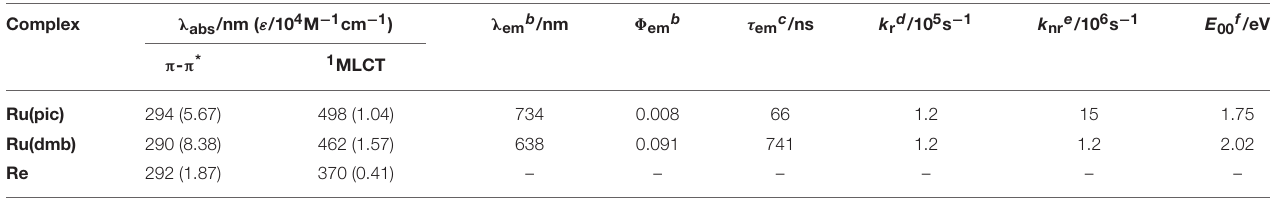
TABLE 1 | Photophysical properties of Ru(pic) , Ru(dmb) , and Re . a .